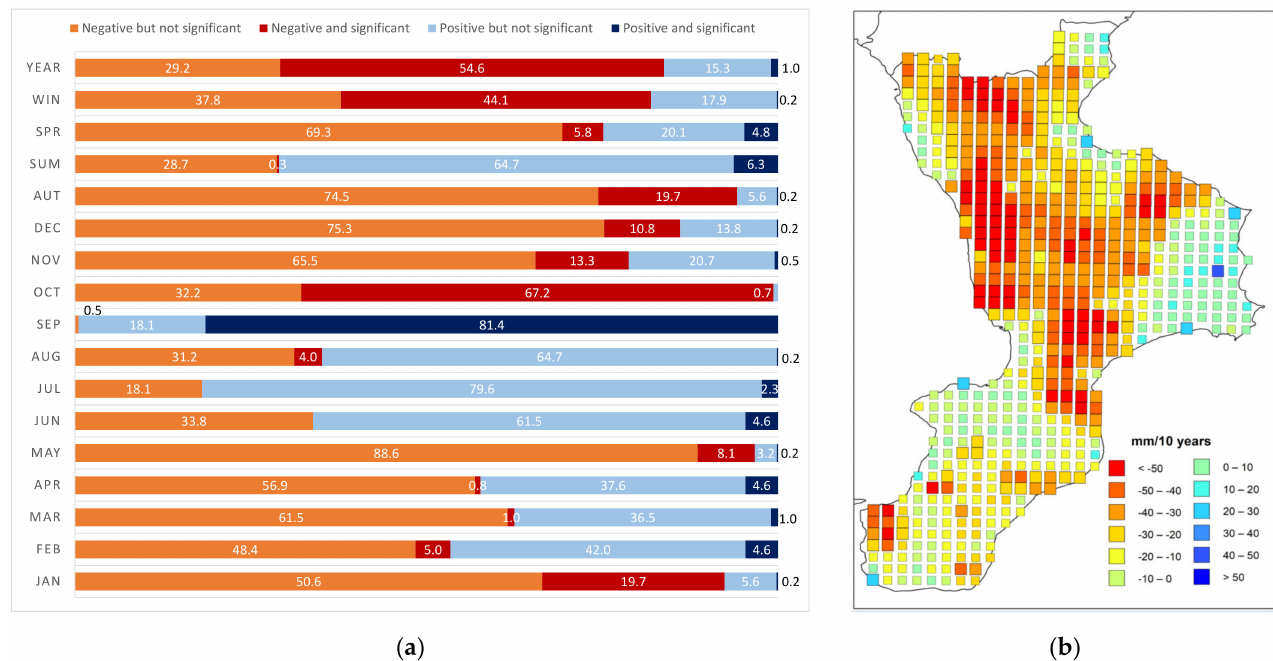
Figure 2. ( a ) Percentages of grid points presenting positive or negative trend; ( b ) Annual trend map. Squares dimension indicates the significance level of the trend: large squares p < 0.05, small squares